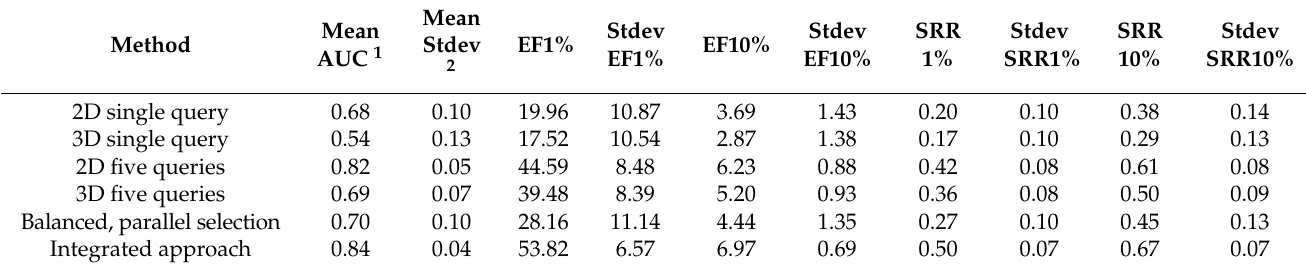
Table 2. Performance of the Investigated Virtual Screening Approaches and